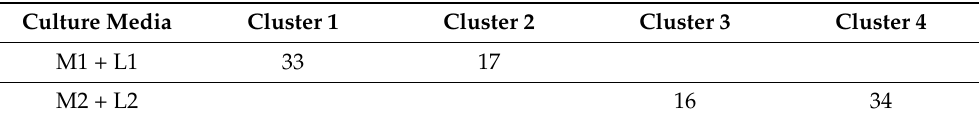
Table 1. Number of hybrid strains of Pleurotus ostreatus growing on different culture media belonging to each cluster using the clustering K-medoids